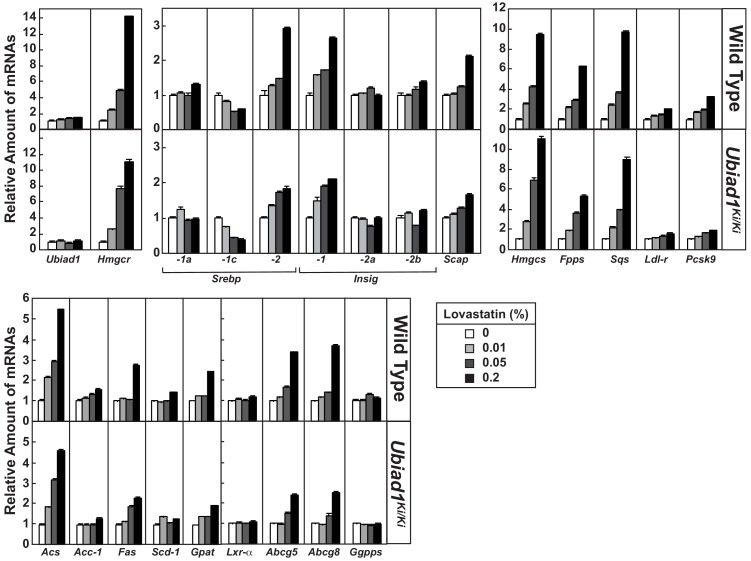
Effect of lovastatin on expression of mRNAs encoding components of the Scap-SREBP pathway in livers of WT and Ubiad1 knock-in mice.Total RNA from livers of mice used in Figure 6A (5 mice/group) was separately isolated. Equal amounts of RNA from the individual mice were subjected to quantitative real-time RT-PCR using primers against the indicated gene; cyclophilin mRNA was used as an invariant control. Each value represents the amount of mRNA relative to that in WT mice fed a chow diet, which was arbitrarily defined as 1. Bars, mean ± S.E. (error bars) of data from five mice.